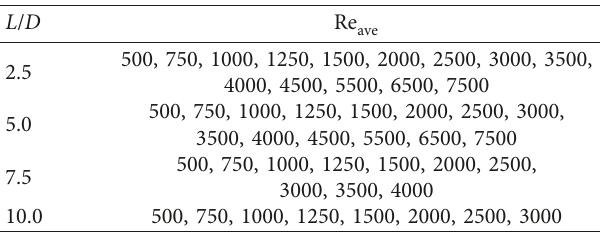
� 1 and Re � 11. W/S N/E